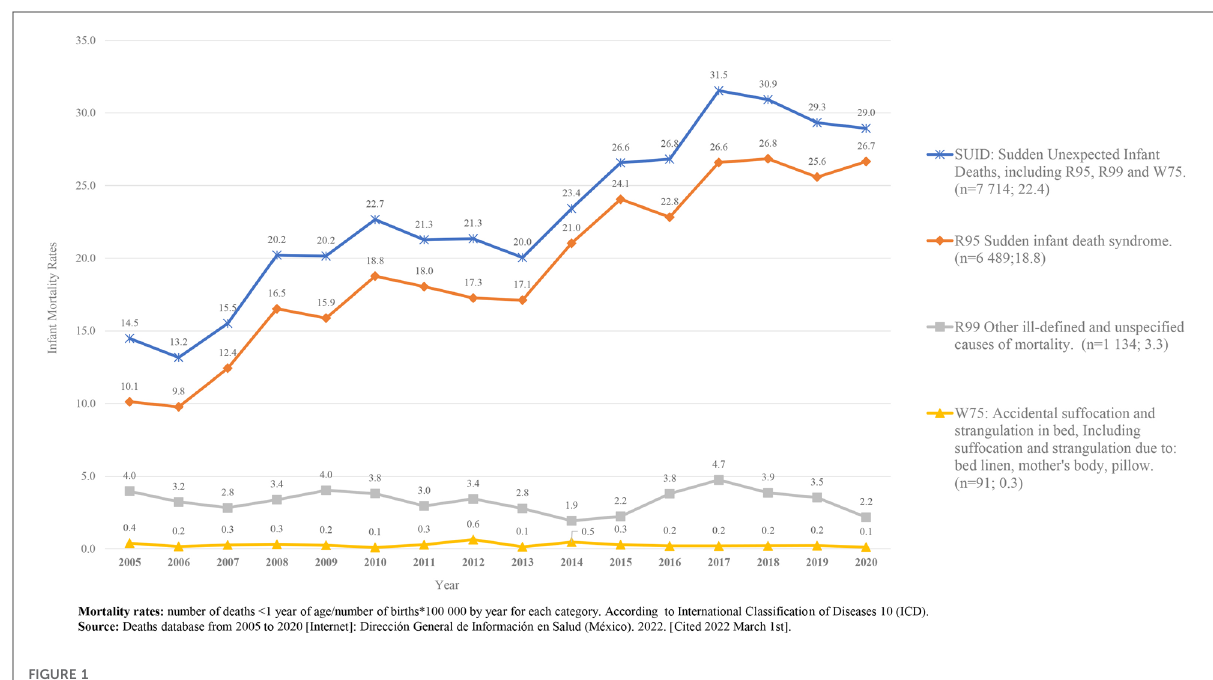
FIGURE 1 Infant mortality rates due to SUID. 2005 – 2020. México